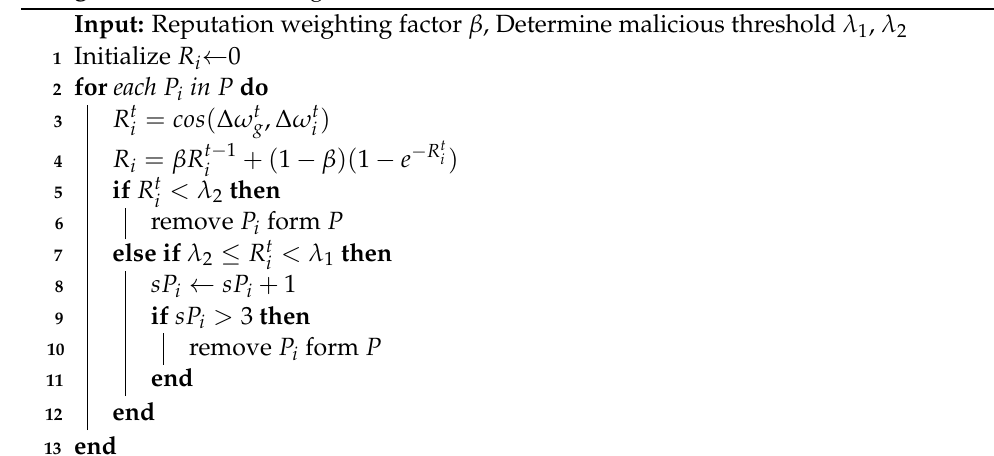
Algorithm 1: MDIFL Algorithm for